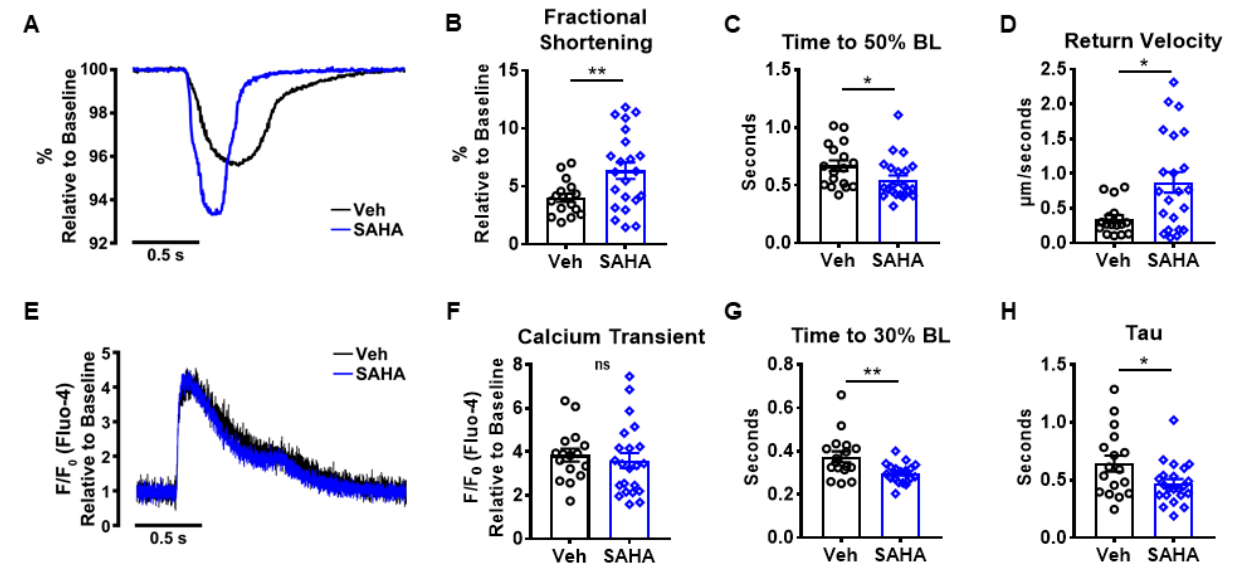
Figure 1. Effect of SAHA treatment on AFVM function. AFVM were isolated and incubated with SAHA or vehicle (2.5 µM) for 90 min, then incubated with Fluo-4am and Pluronic™ F-127 before functional measurements were acquired. ( A ) Representative contraction of SAHA treated vs. vehicle AFVM, which had an improvement in ( B ) fractional shortening, ( C ) Time to 50% baseline of contraction and ( D ) return velocity. ( E ) Representative calcium transient showing no difference between SAHA and vehicle-treated AFVM ( F ) peak calcium transient, but there was a decrease in ( G ) time to 30% baseline and ( H ) tau; n = 17–22 myocytes/parameter from 4 felines. Fractional shortening and tau were analyzed using two-sided Student’s t -test. Time to 50% BL, return velocity, calcium transient, and time to 30% BL were analyzed using Mann–Whitney test. NS stands for not significant. * p < 0.05, ** p < 0.01. Data shown are means ± SEM.